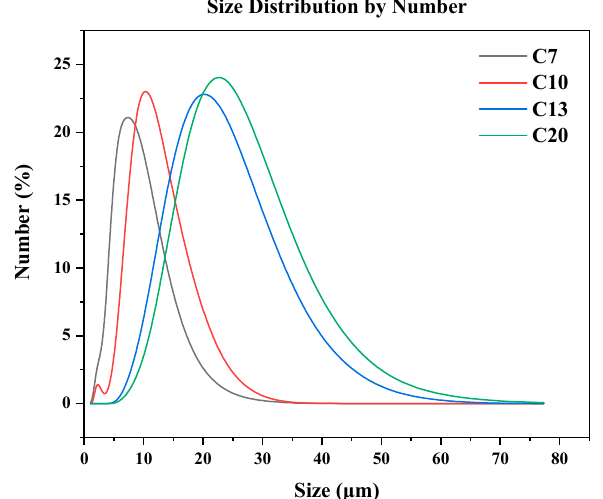
Figure 1. Particle size distribution of the corundum grains for preparing the ceramic membranes.